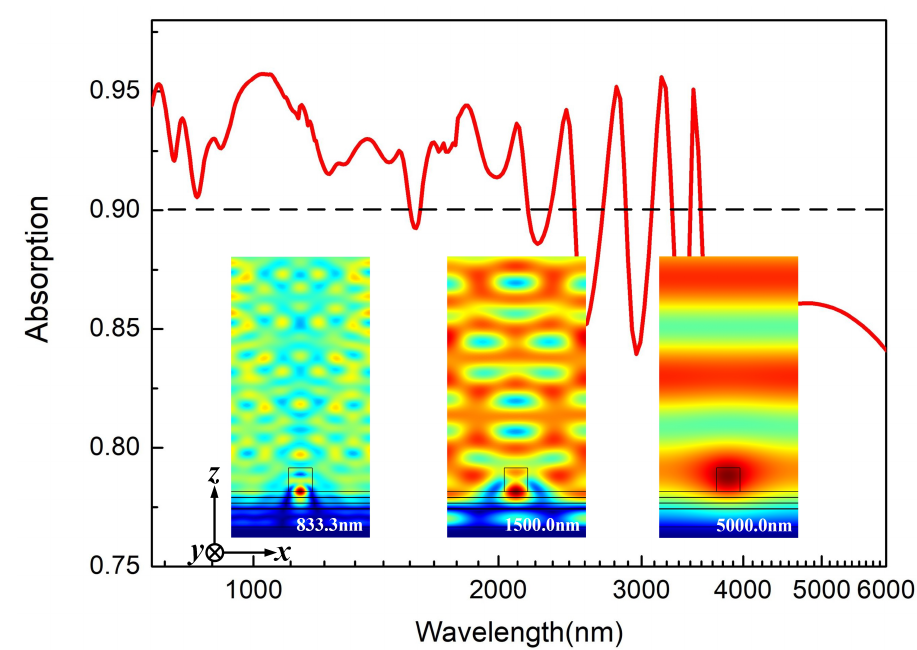
Figure 3. Absorption spectrum of ordinary grating in Figure 1b supported by three-layer SFSS over the wavelength range from 750 nm to 6000 nm; The illustrations are electric field distribution in the vertical direction at the wavelength of 833.3 nm, 1500.0 nm and 5000.0 nm,